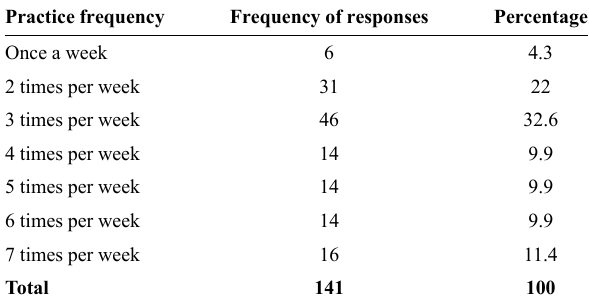
Table 2 - Distribution of responses per training frequency.